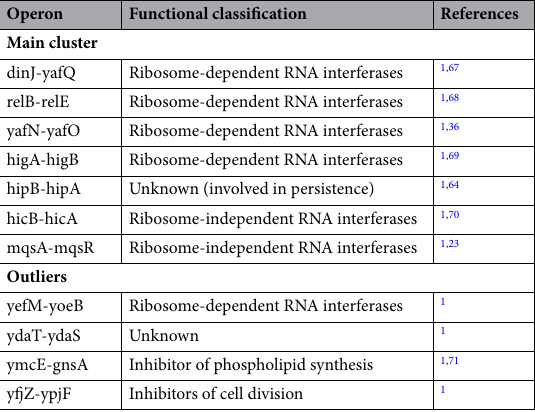
Table 1. Identified clusters and their functional